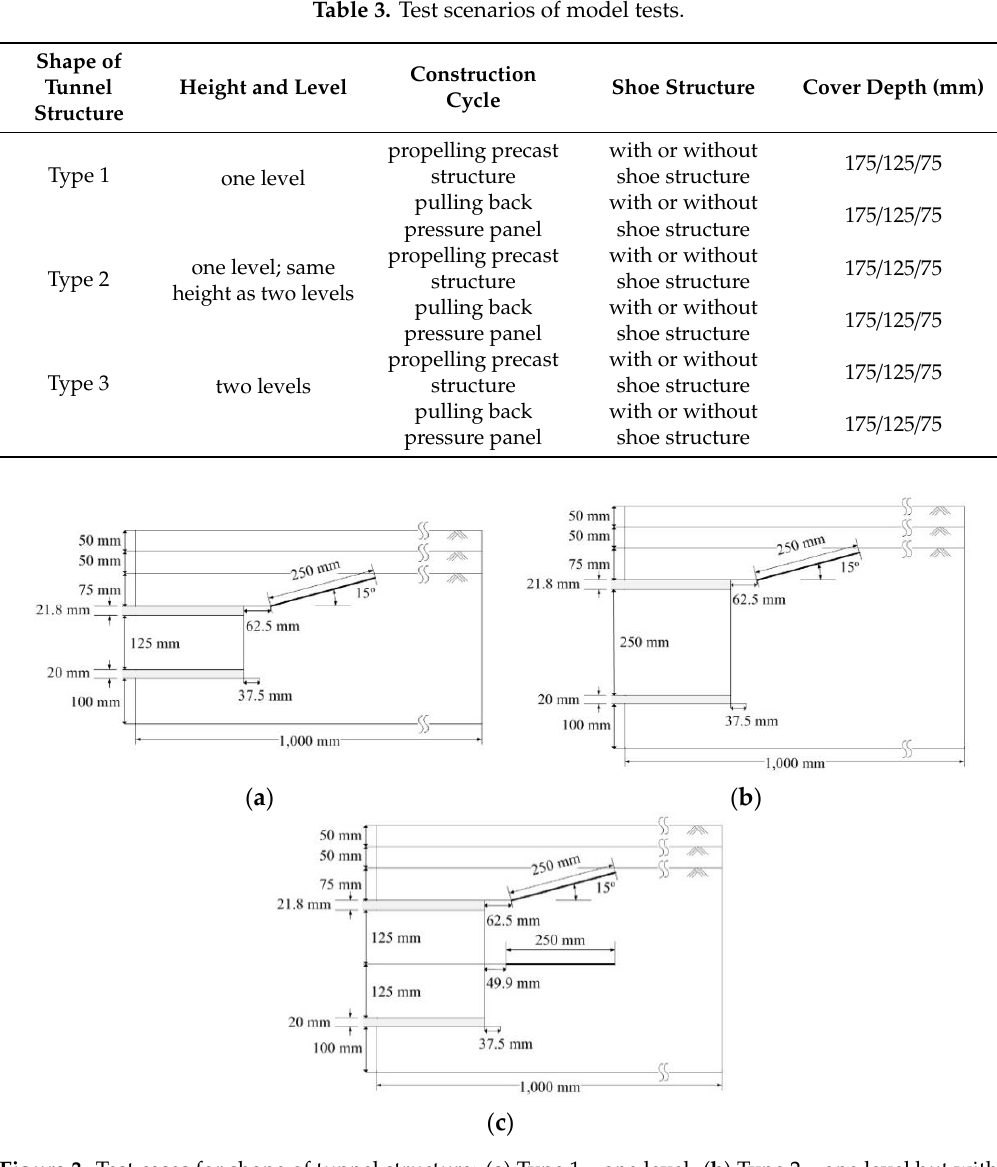
Figure 3. Test cases for shape of tunnel structure: ( a ) Type 1—one level. ( b ) Type 2—one level but with same height as two levels. ( c ) Type 3—two levels.